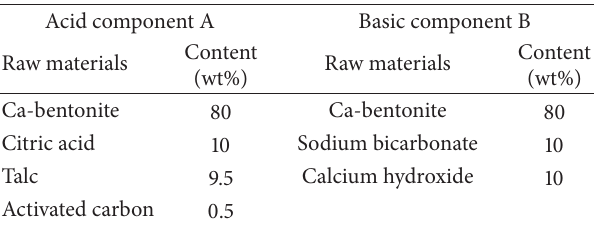
Table 1: The compositions and the mass ratio of acid component A and basic component